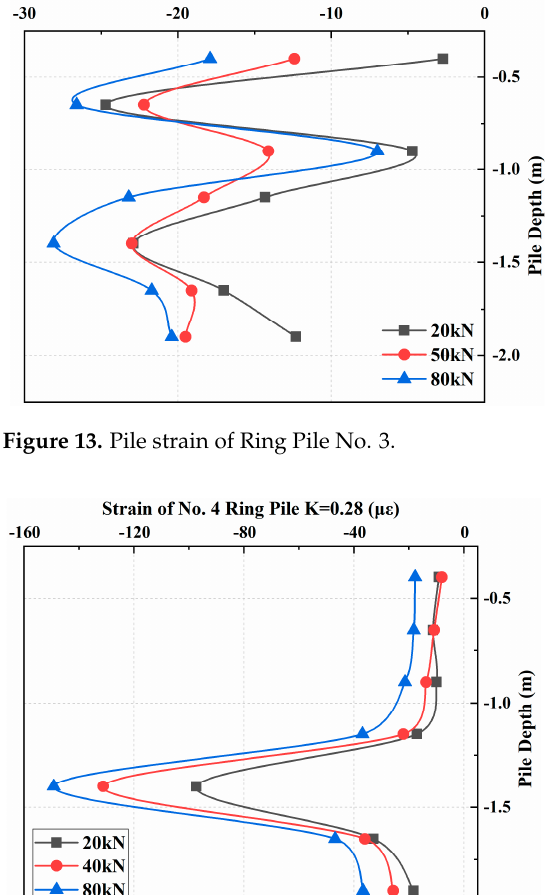
Figure 14. Pile strain of Ring Pile No. 4.